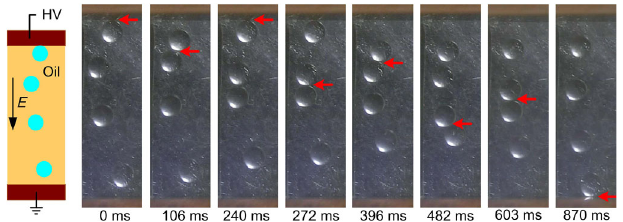
FIG. 2. Experiments within silicone oil: Four glass beads ( r ¼ 1 mm) bouncing between two high-voltage metal electrodes ( E ¼ 2 . 5 kV = cm). The arrows indicate the locations of charge exchange during each bounce. All pictures show the view from the top of the cell.